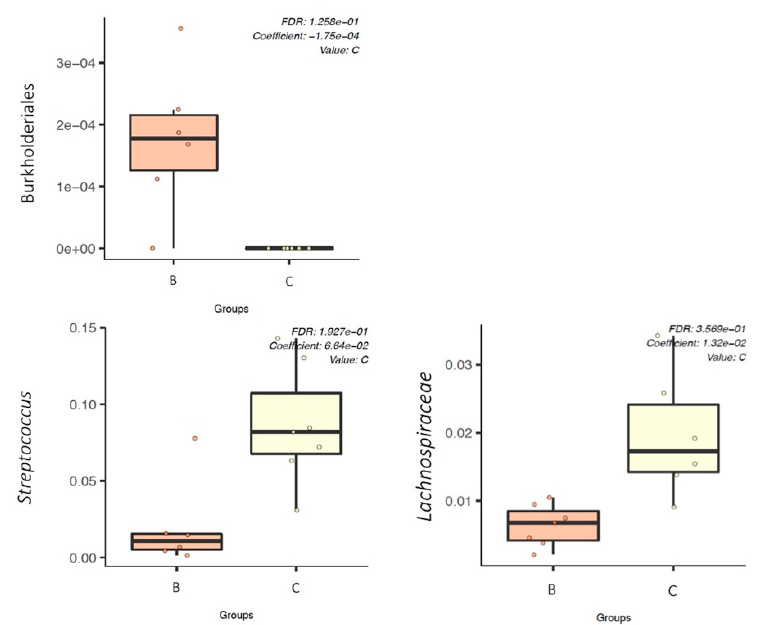
Figure 7. Boxplot showing the relative abundance (using MaAslin2) of the fecal microbiota biomarkers (order of Burkholderiales , genus of Streptococcus , and family of Lachnospiraceae ) between groups B and C at Day 36. B —challenged treated group. C —unchallenged treated group.